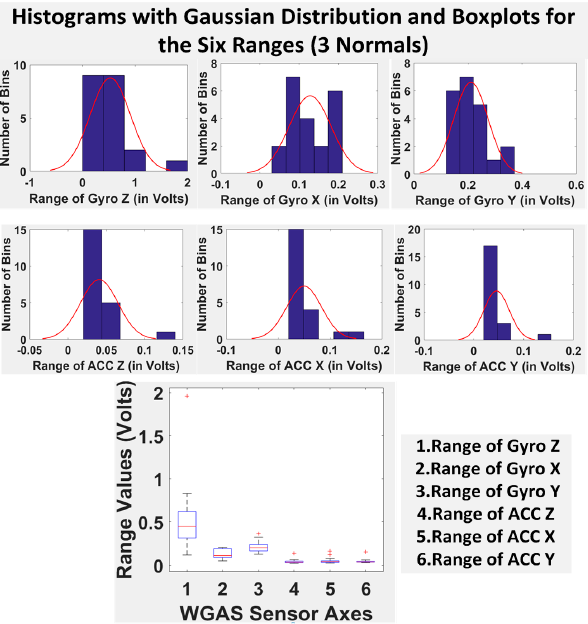
Figure 9. Histograms with the Gaussian distribution and box plots for the six ranges combining all of the DGI tests from the three normal subjects.